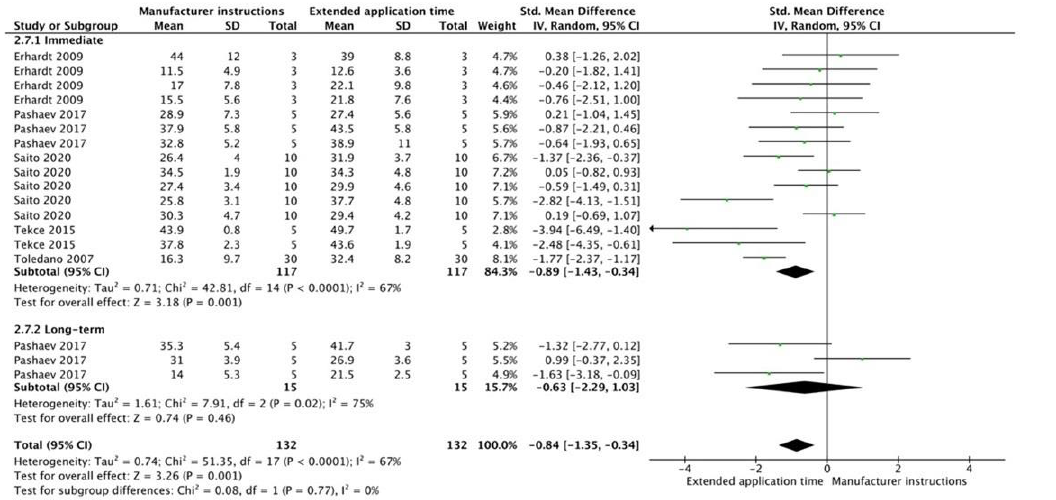
Figure 8. Forest plot showing the bond strength values when the adhesive was covered with a hydrophobic resin layer [64–66,90–95].